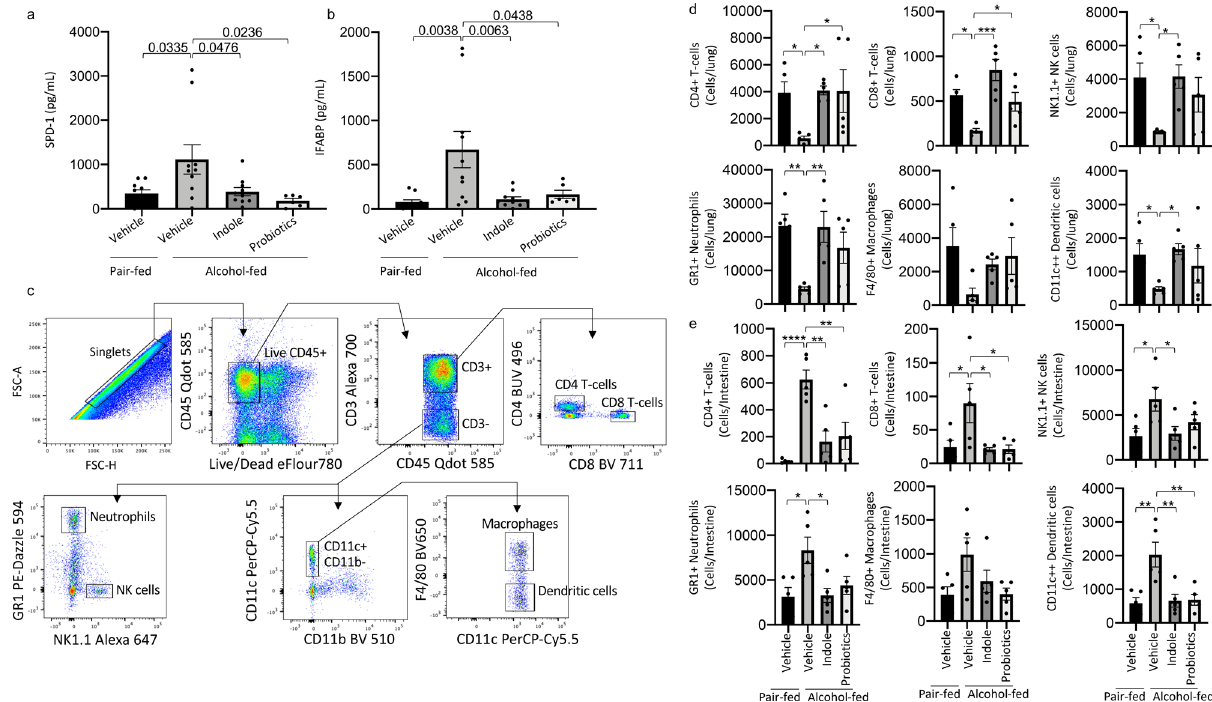
Fig. 2 Microbiota supplementation mitigates alcohol-associated permeability and immune dysfunction. Binge-on-chronic alcohol-fed mice with and without treatment were infected with Klebsiella and sacri fi ced 48 h post-infection. a Levels of circulating surfactant protein D1 (SPD-1). b Levels of circulating intestinal fatty acid binding protein (IFABP). c Flow cytometry gating strategy. d Number of pulmonary immune cells in binge-on-chronic alcohol-fed mice with and without treatment infected with Klebsiella . e Number of intestinal immune cells in binge-on-chronic alcohol-fed mice with and without treatment infected with Klebsiella . Bars represent the mean ± SEM and dots represent individual mice. P values are indicated in the fi gure or denoted by * P < 0.05, ** P < 0.001, *** P < 0.0001, **** P < 0.00001, $ P < 0.000001, as determined by one ‐ way ANOVA with Sidak ’ s multiple comparison test. N =